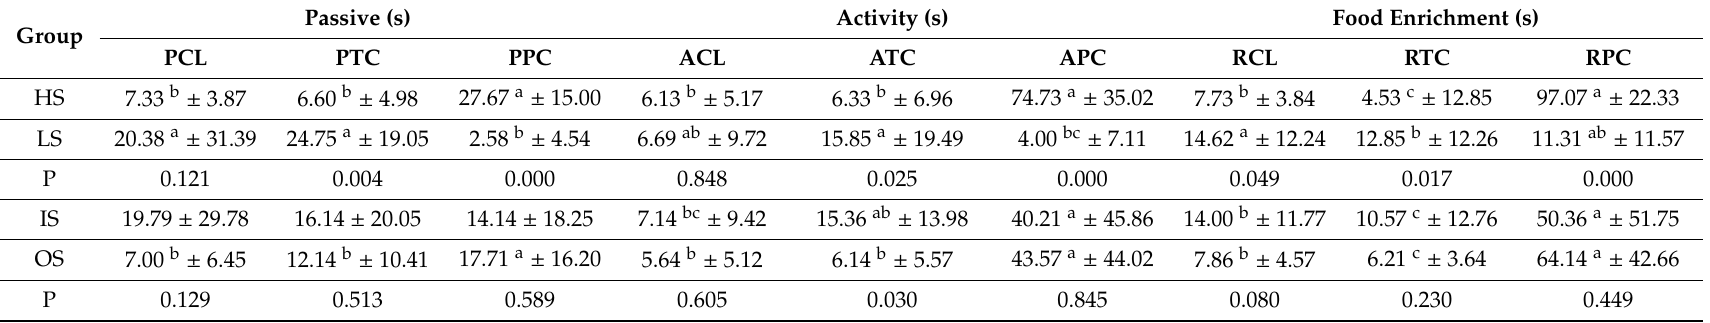
Table 2. Results of the nine social behavior test